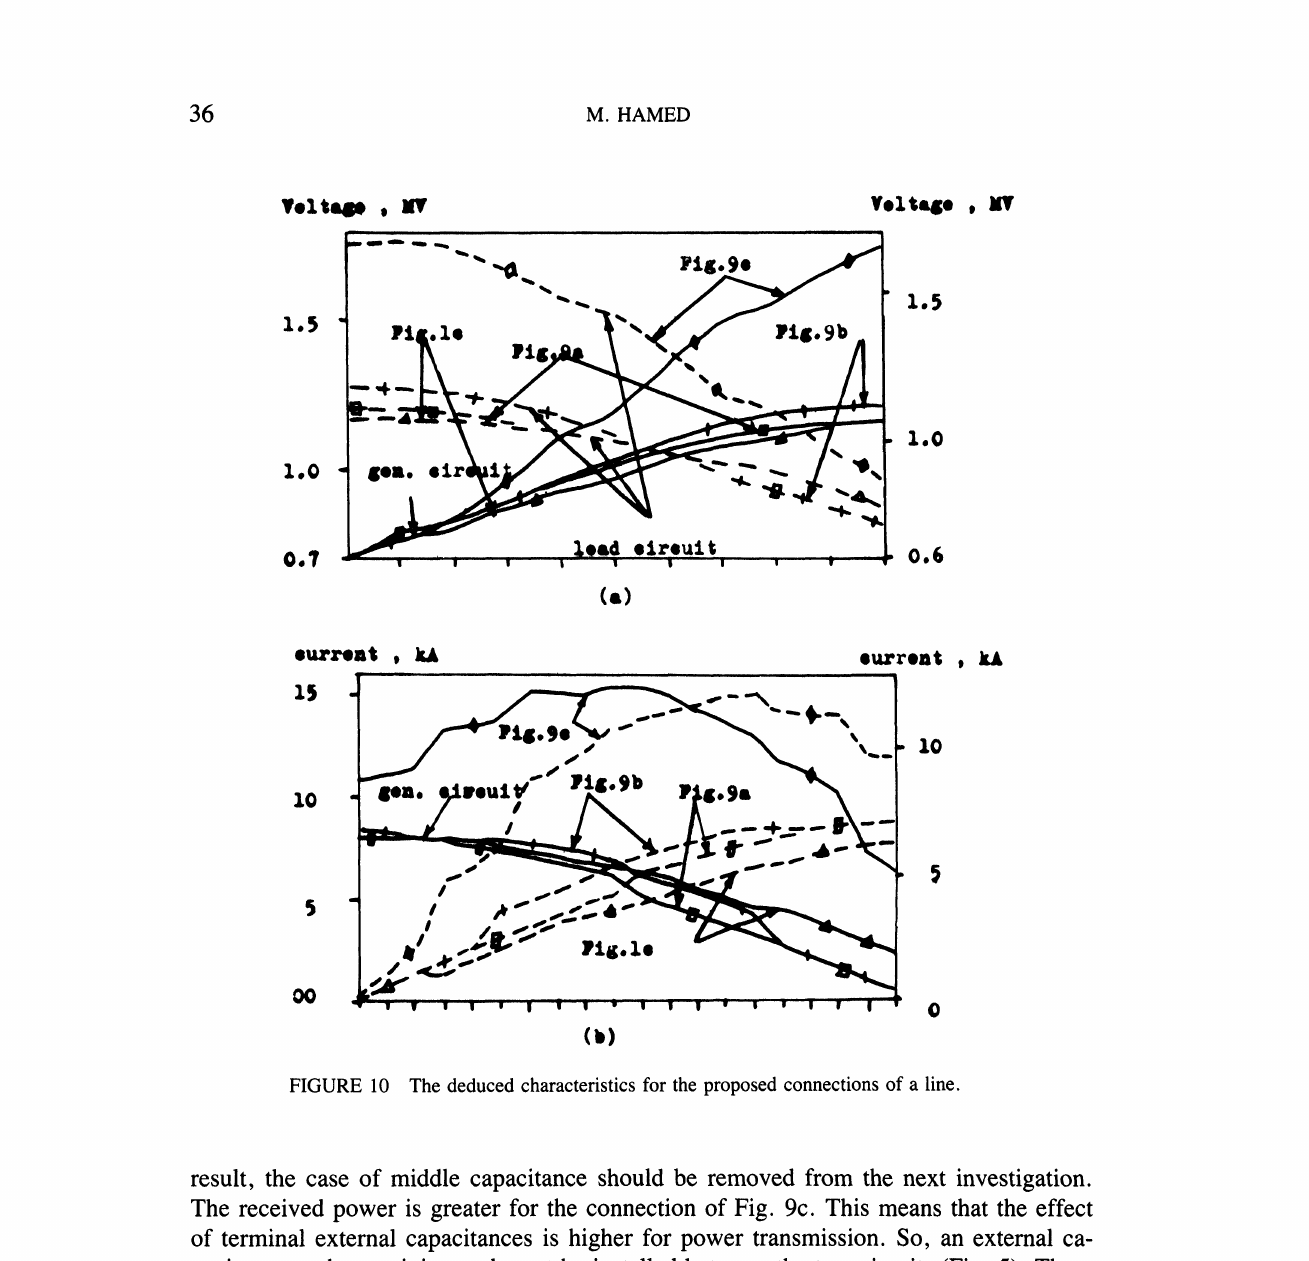
FIGURE 10 The deduced characteristics for the proposed connections of a